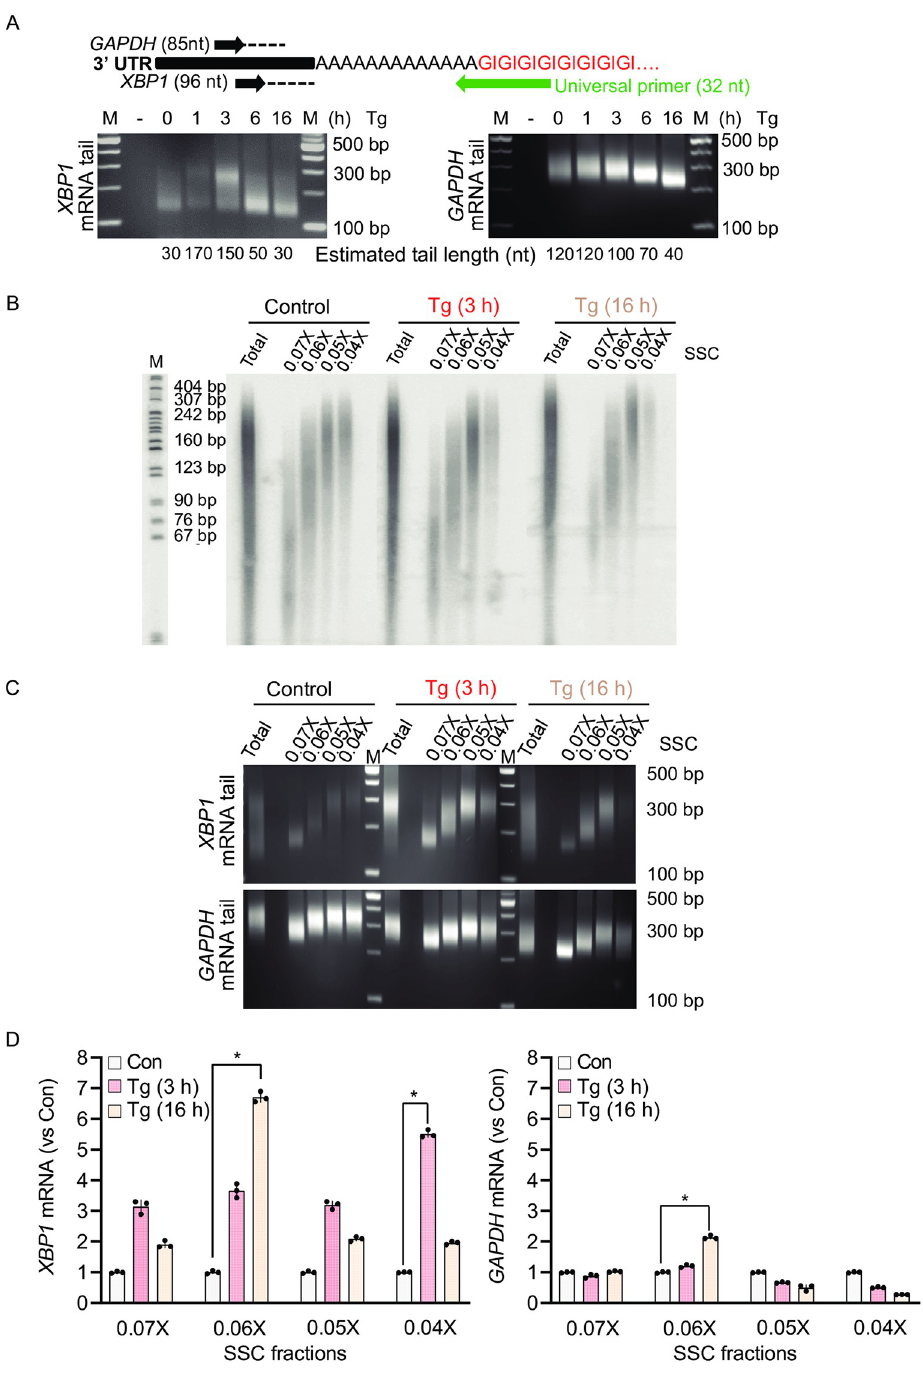
Fig 2. Acute UPR does not involve an increase of global poly(A) tail length of mRNAs. (A) (top) Experimental diagram of the PCR-based poly(A) tailing assay [49] for XBP1 and GAPDH mRNAs. The 3’-end of total RNA was modified with GMP/IMP residues by poly(A) polymerase to form a GI-oligo tail connected to the poly(A) tail. Following RNA isolation and RT, universal primers were used as a reverse primer for cDNA amplification of targets. (Bottom) PCR-based poly(A) tailing assay in MEFs treated with Tg for the indicated durations. Estimated tail lengths are shown. As a negative control (-), a tail reaction was performed on cDNA derived from RNA not tagged with the GI-oligo tail. (B) mRNA fractionation based on poly(A) tail length in MEFs treated with Tg for the indicated durations. 3 h of Tg treatment represents acute ER stress, and 16 h of Tg treatment represents chronic ER stress. (C) The poly(A) tail length of XBP1 and GAPDH mRNA was estimated using the PCR-based poly(A) tailing assay in